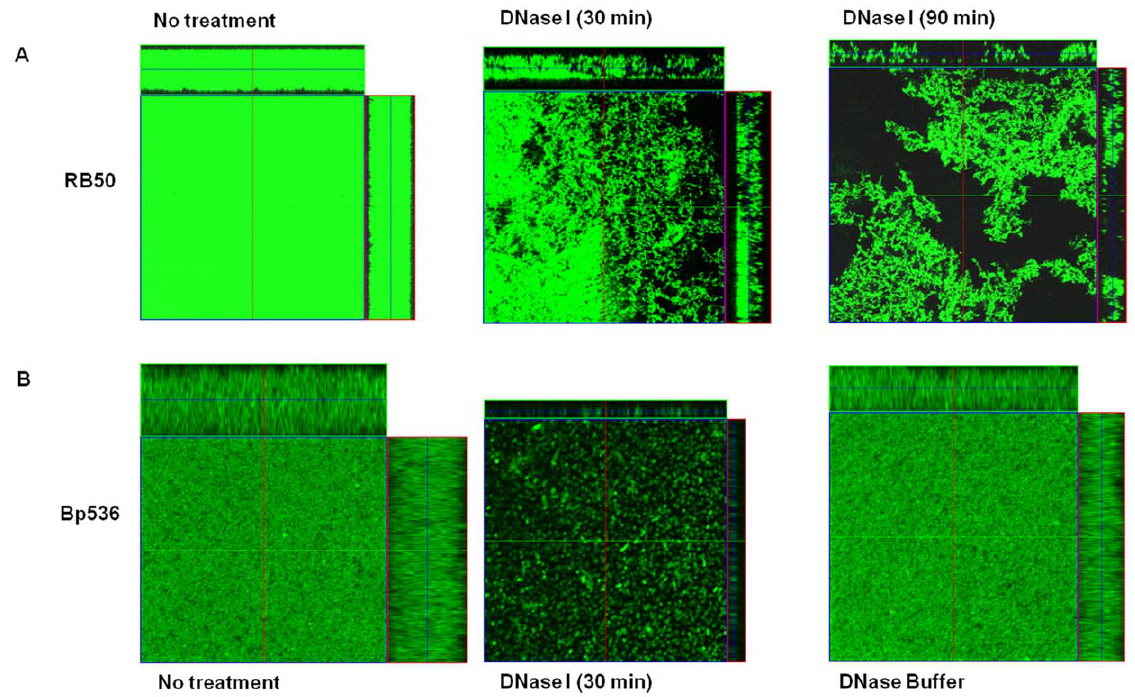
Figure 4. DNase I leads to the disruption of established Bordetella biofilms grown on glass coverslips under static conditions. Biofilms were grown on glass coverslips for 48h for RB50 (A) and 96 h for Bp536 (B). The coverslips were gently rinsed followed by treatment with DNase I for either 30min or 90min. The cells were tagged with GFP and thus are green. For each micrograph, the middle panel represents the x-y plane, and the adjacent top and side panels represent the x-z and y-z planes, respectively. The images of a biofilm not treated with DNase I and treated only with DNase I buffer are also depicted. CLSM was utilized to image the biofilms.